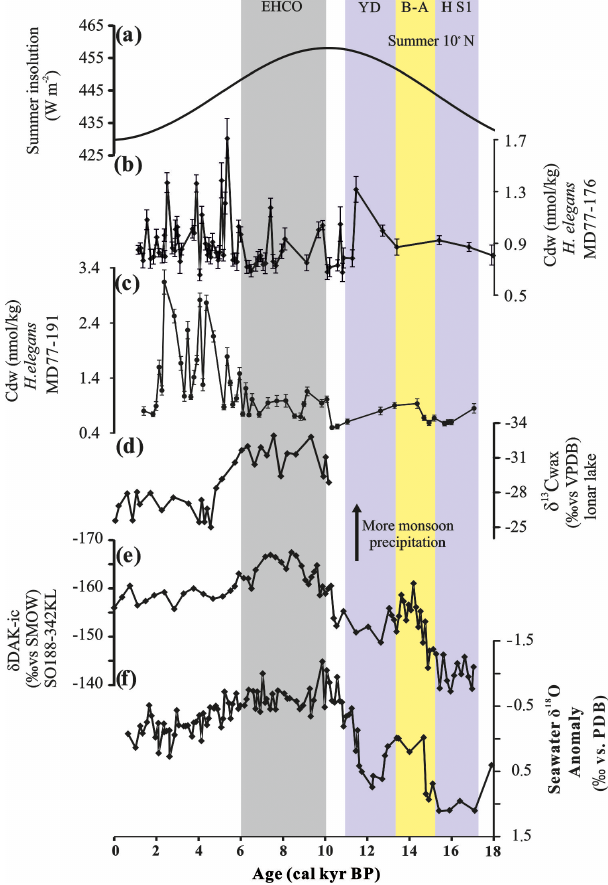
Figure 6. (a) The solar insolation at 10 ◦ N in summer (Laskar et al., 2004). (b, c) Intermediate Cd w calculated from H. elegans obtained from MD77-176 and MD77-191, respectively. (d) Lonar Lake δ 13 C wax record (Sarkar et al., 2015). (e) δ D Alk − ic record from core SO188-342KL (Contreras-Rosales et al., 2014). (f) Seawater δ 18 O anomaly obtained from MD77-176 (Marzin et al., 2013). The color-shaded intervals and abbreviations are the same as in Fig.